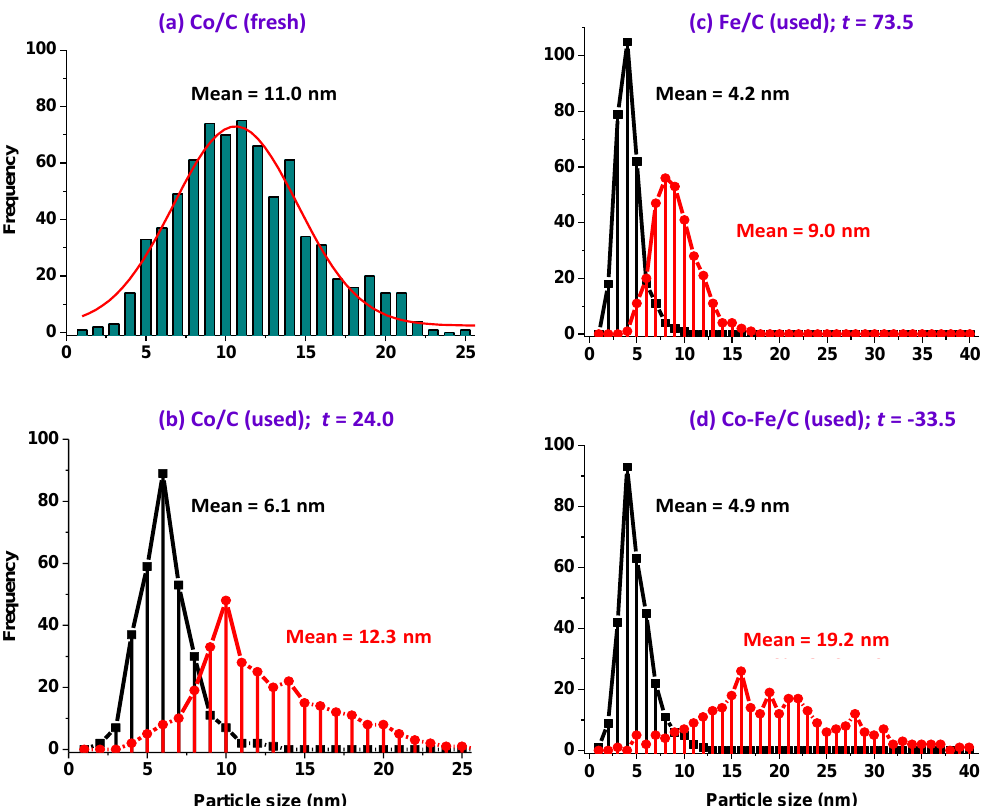
Figure 14. The particle size analysis by TEM imaging showing ( a ) a mono-modal nanoparticle distribution in the fresh Co/C catalyst [47]. ( b ) Bi-modal distribution in the used Co/C. ( c ) Bi-modal distribution in the Fe/C sample, and ( d ) multi-modal distribution in the used Co-Fe/C catalyst.